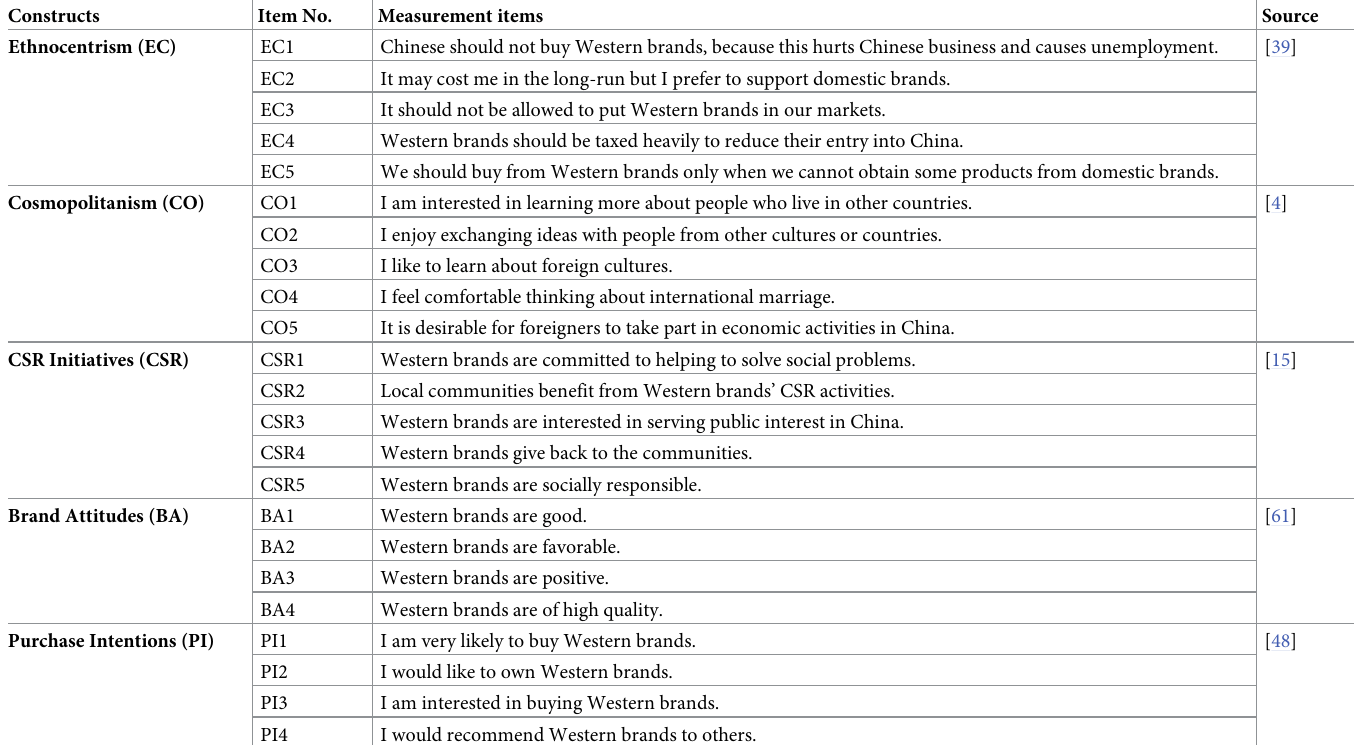
Table 1. Questionnaire